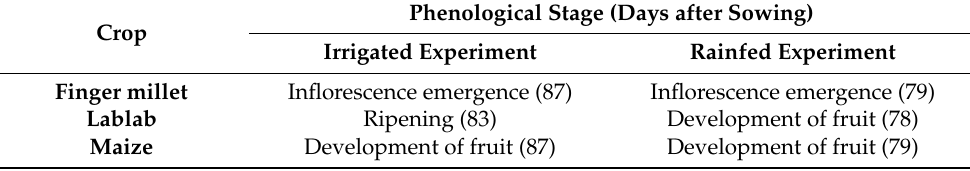
Table 1. Phenological stages of the crops when the remote sensing and in-situ data were collected. Based on Table A3 from [29].